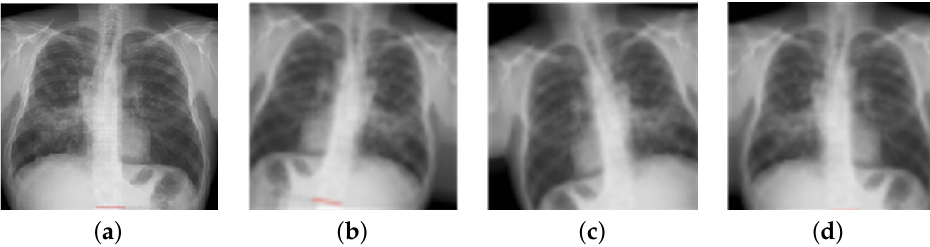
Figure 9. Images of chest X-rays after using random data augmentation techniques: ( a ) original, ( b ) after clockwise rotation by 10 degrees, ( c ) after anti-clockwise rotation by 10 degrees, and ( d ) after 10%